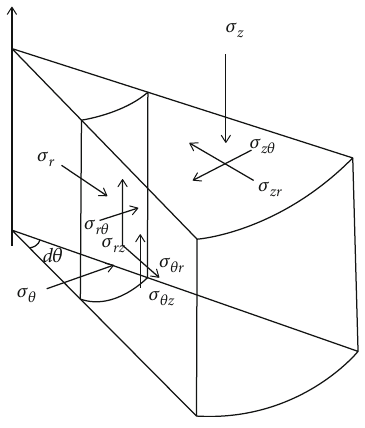
Figure 3: Microunit stress around the